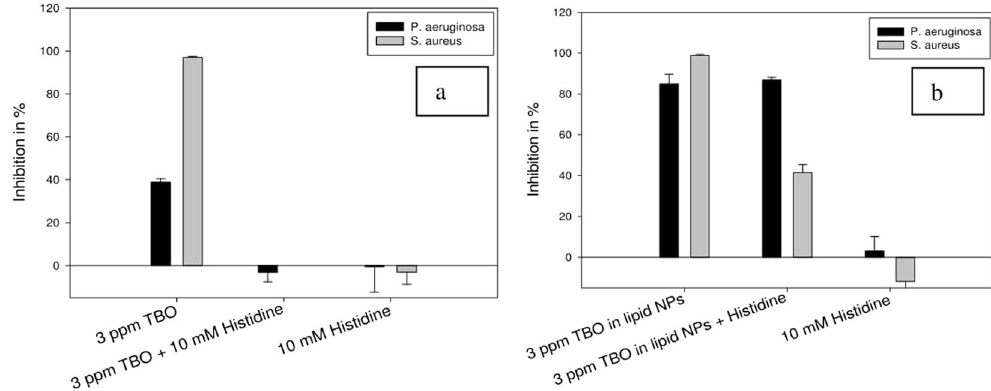
Figure 8. Effect of L-histidine combined with ( a ) TBO in water and ( b ) TBO in lipid nanoparticles on inhibition of P . aeruginosa and S . aureus - Inhibition was reduced to almost nil in the cases of both the strains of bacteria when TBO in water was combined with L-histidine. However, inhibition of S . aureus showed a decrease when TBO in lipid nanoparticles was combined with L-histidine. On the other hand, inhibition of P . aeruginosa remained unchanged after combination of TBO in lipid nanoparticles with